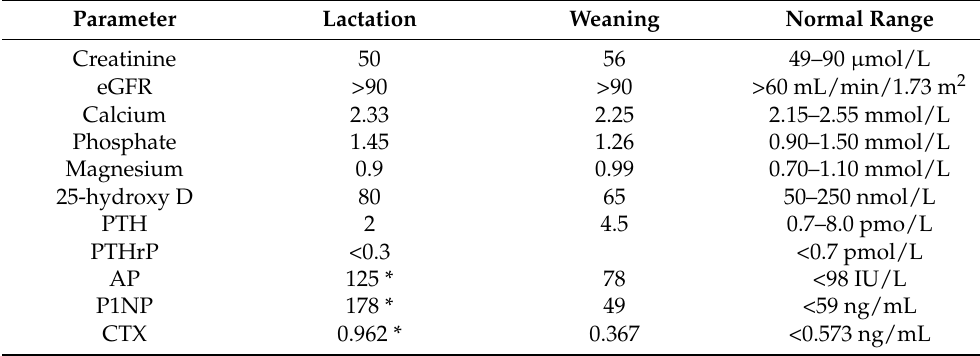
Table 1. Biochemical parameters of a woman with pycnodysostosis during lactation and